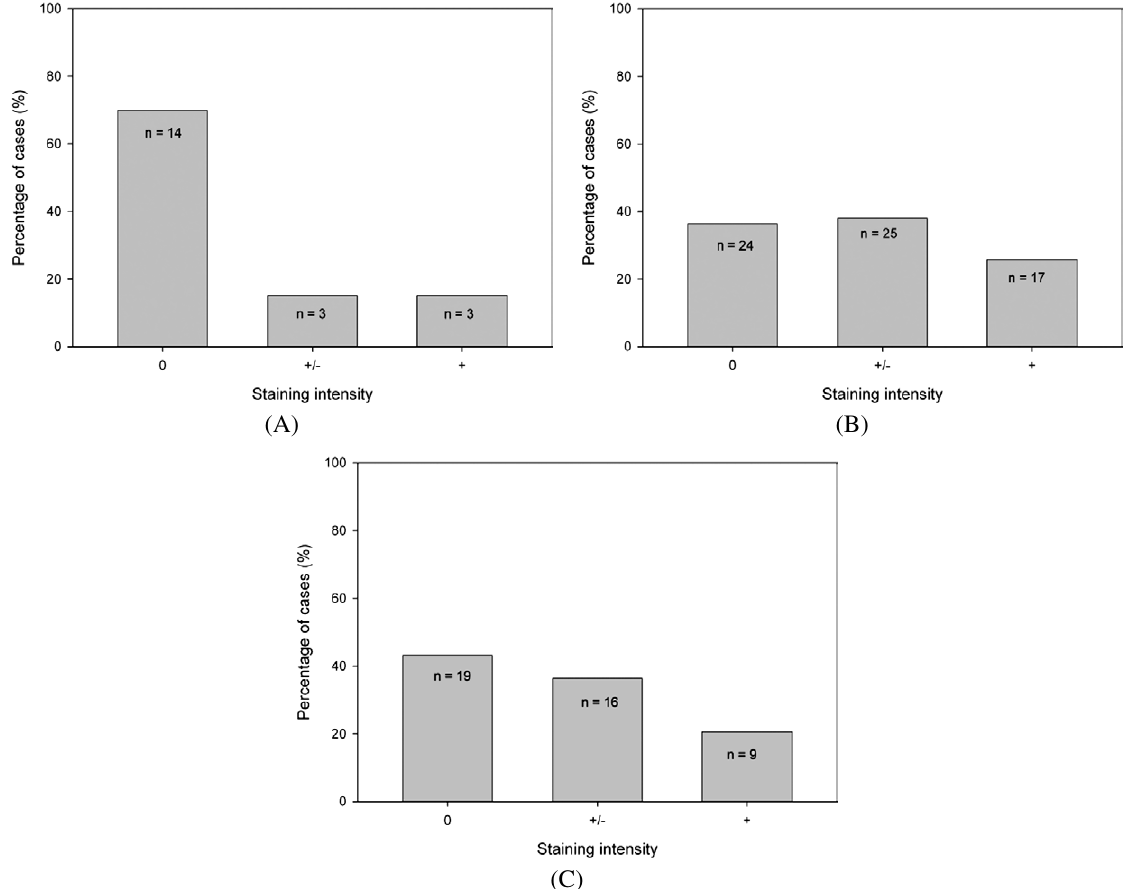
Fig. 2. Cytoplasmic expression of caspase-8 in normal colon tissue (A), colorectal adenomas (B) and colorectal carcinomas